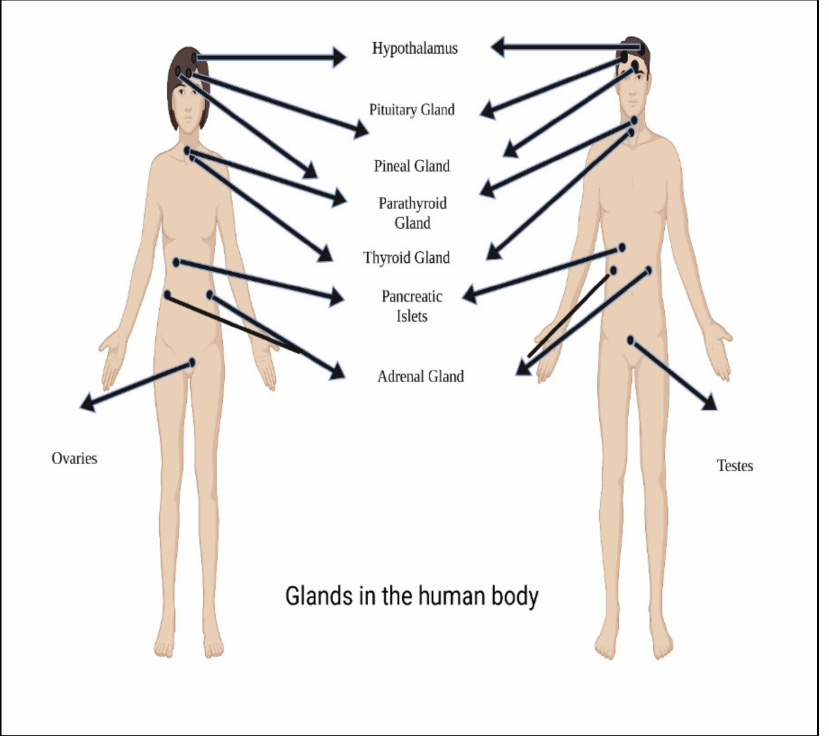
Figure 3. Main glands in the human